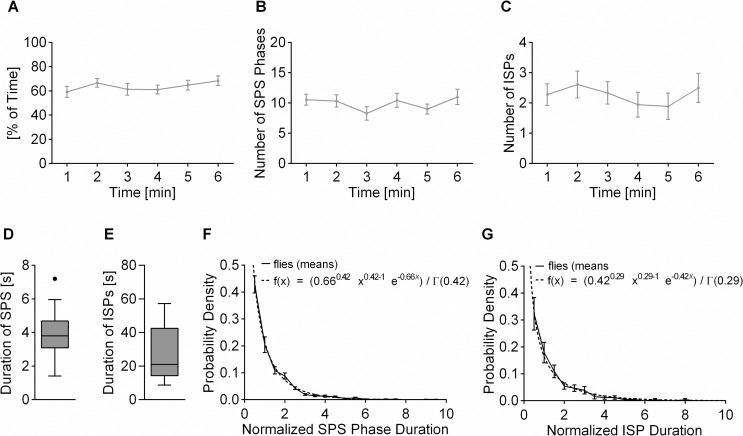
Temporal dynamics and behavioral stability over time in the TPMP.(A), SPS did not change over time. Mean SPS values per minute measured with random dots patterns at 8% contrast (mean ± SEM; n = 18 flies; F(3.84, 65.21) = 0.94, p = 0.446, R2 = 0.052, rm-ANOVA). (B), Number of SPS phases did not change over time. Mean number of SPS phases per minute (Q(5) = 7.45, p = 0.189, Friedman test). (C), Mean number of ISPs per minute. One ISP was detected as onset of SPS 1 when the last SPS was SPS 2 and vice versa (Q(5) = 5.502, p = 0.357, Friedman test). (D), Mean duration of SPS phases differed among flies. Duration of one SPS phase was calculated as t(SPS1_offset)-t(SPS1_onset) or t(SPS2_offset)-t(SPS2_onset), respectively. Tukey-Boxplot. (E), Mean duration of ISPs differed strongly among flies. Duration of one ISP was calculated as t(SPS2_onset)-t(SPS1_onset) or t(SPS1_onset)-t(SPS2_onset). Tukey-Boxplot. (F), Probability distribution of normalized SPS phase duration fit gamma distribution (R2 = 0.84). Individual SPS durations were normalized to the mean SPS phase duration of the respective fly. A replicates test for lack of fit showed no lack of fit (F = 0.24, p = 0.999). (G), Probability distribution of normalized ISP duration fit gamma distribution (R2 = 0.55). Single ISP durations were normalized to the mean ISP phase duration of the respective fly. A replicates test for lack of fit showed no lack of fit (F = 0.13, p = 1). Underlying data can be found in S1 Data and https://doi.org/10.6084/m9.figshare.4668376.v1. ISP, inter-switch-phase; SPS, single pattern stabilization; TPMP, transparent panorama motion paradigm.